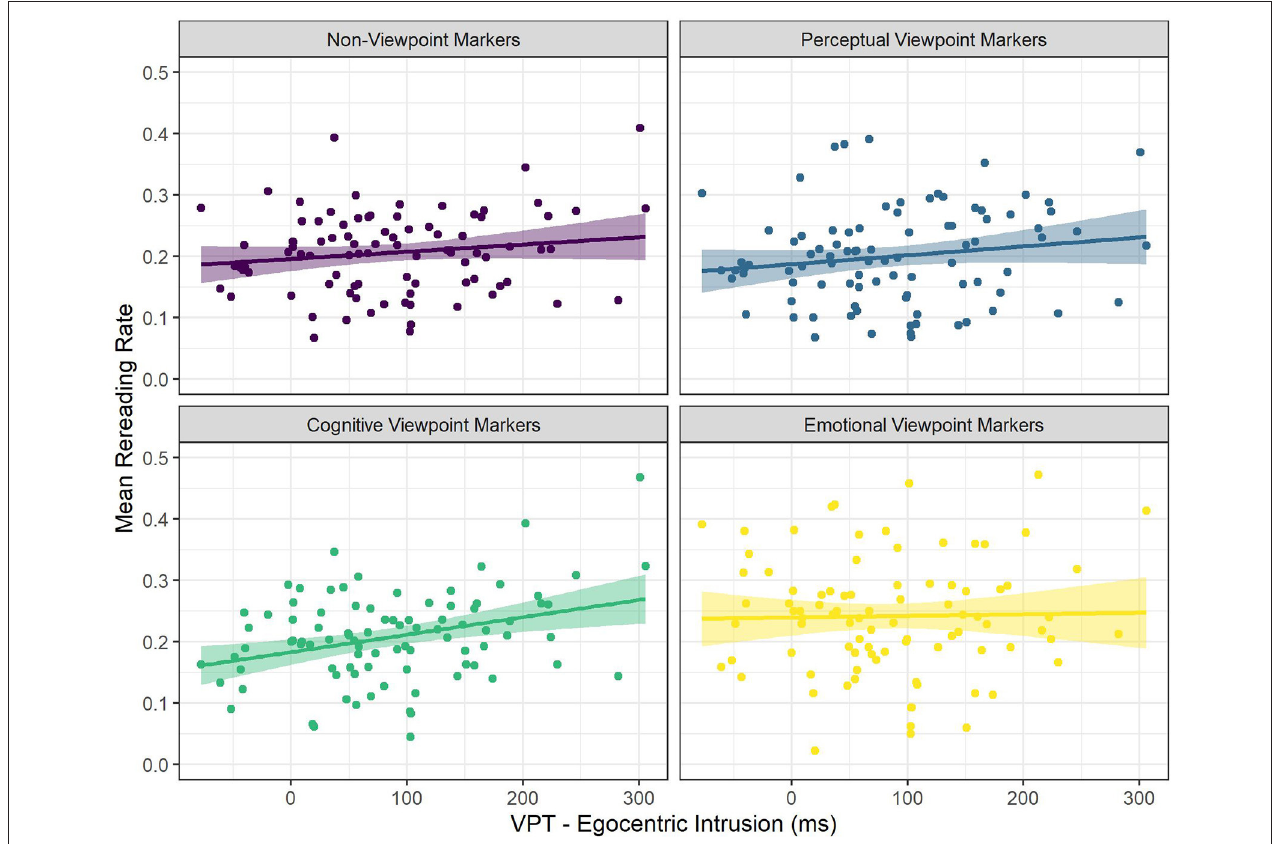
FIGURE 5 | The Relationships Between Mean Rereading Rate and Egocentric Intrusion for the Different Categories of Viewpoint Markers. Each Dot Represents a